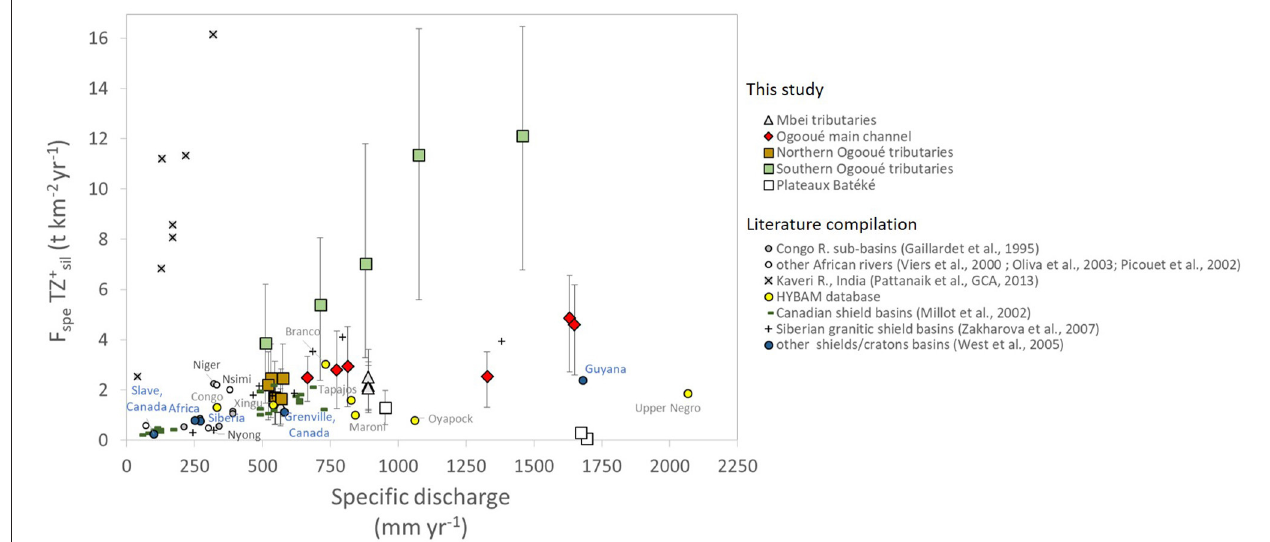
FIGURE 10 | Silicate weathering rate ( F spe TZ + sil in t km − 2 yr − 1 ) vs. specific discharge ( Q spe ) for rivers of the Ogooué and Mbei basins, and of other rivers draining cratons at the global scale. The HYBAM database provides major elements fluxes for the Upper Negro, Branco, Xingu, and Tapajos ( Moquet et al., 2016), Oyapock and Maroni (Sondag et al., 2010) and Congo (Laraque et al., 2009) for the period 2003–2019. Values of F spe TZ + sil for the HYBAM stations here correspond to the cation fluxes corrected from the atmospheric inputs, according to the method used in the present study. The remaining cations rate were considered to be only derived from silicate weathering. Error bars reflect uncertainties, the calculation of which is detailed in section Uncertainty